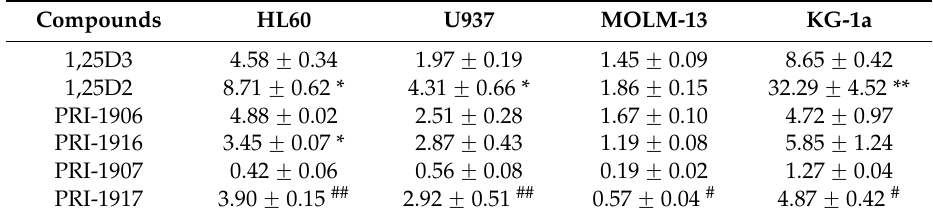
Table 1. Comparative differentiation-inducing potencies of vitamin D derivatives in acute myeloid leukemia (AML) cells.